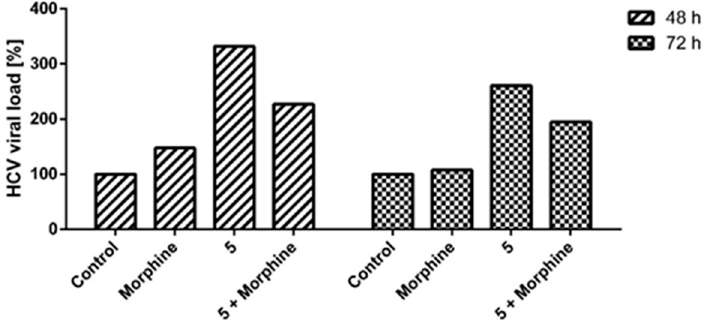
Figure 8. Effect of the co-administration of morphine (1.00 µM) and compound 5 (25.00 µM) on HCVg1b replication in the Huh7.5 SG cells at 48 and 72 h.